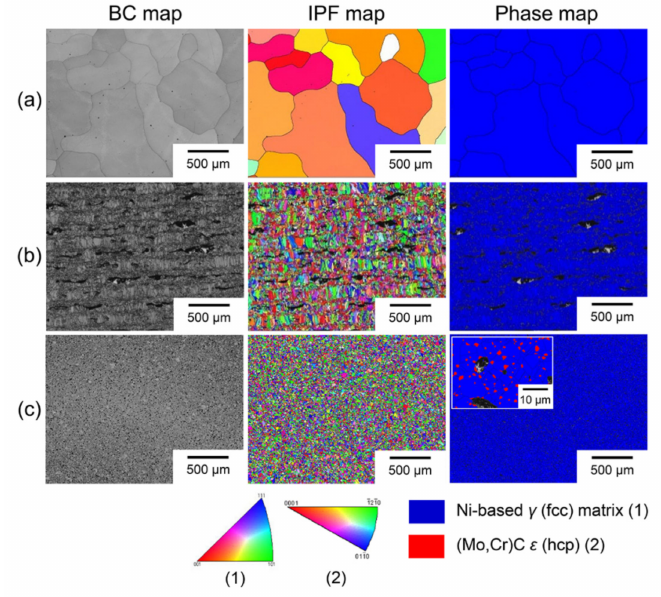
Figure 6. EBSD images of Ni–Cr–Mo alloys (magnification = 100 × ): LWC ( a ), SLM ( b ), and SMM ( c ). Rectangular image within phase map ( c ) shows higher magnification, clearly revealing two different phases (magnification = 3000 × ).